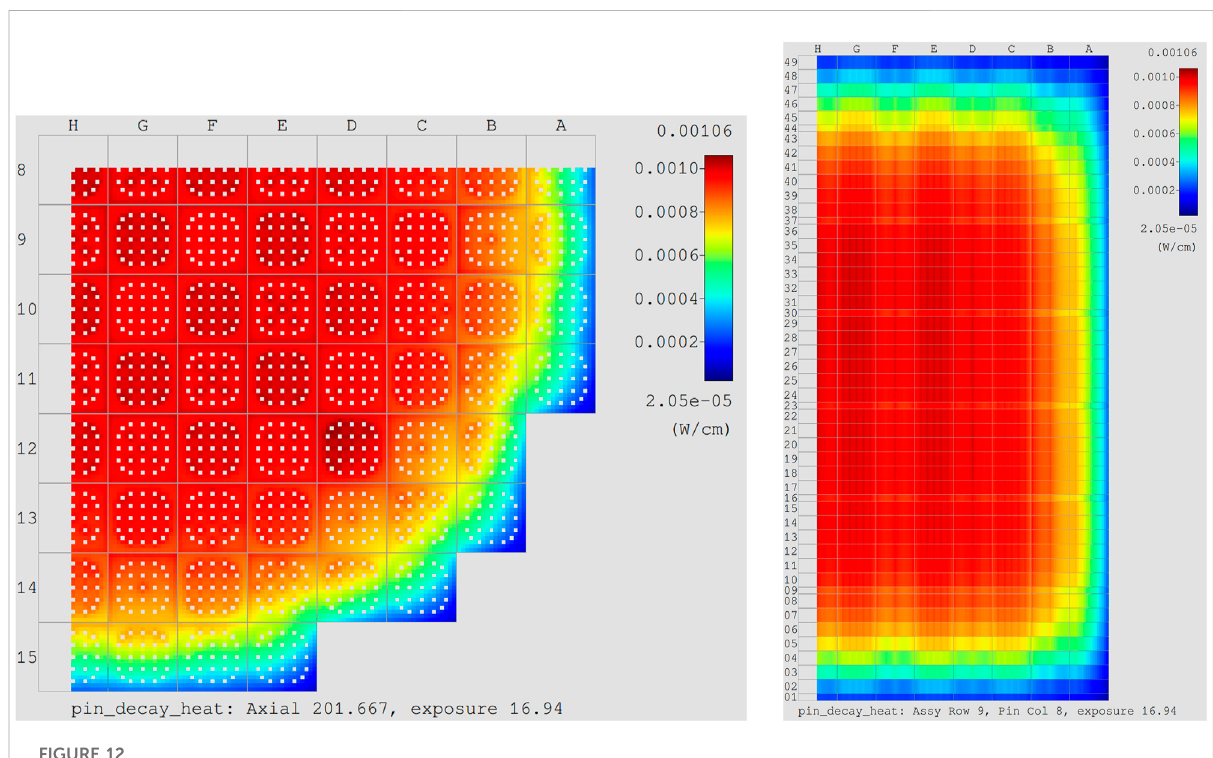
Radial and axial decay heat distribution after 100 years of